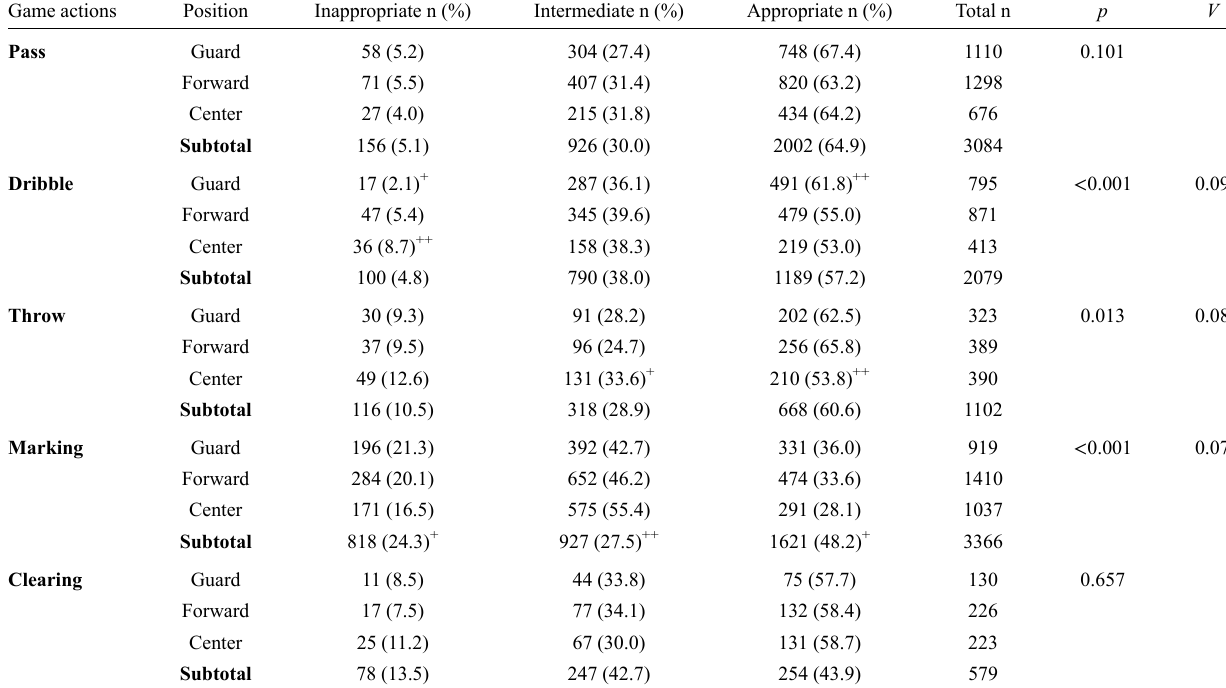
Table 3 - Decision making level in game actions, considering the players’ positions. Game actions